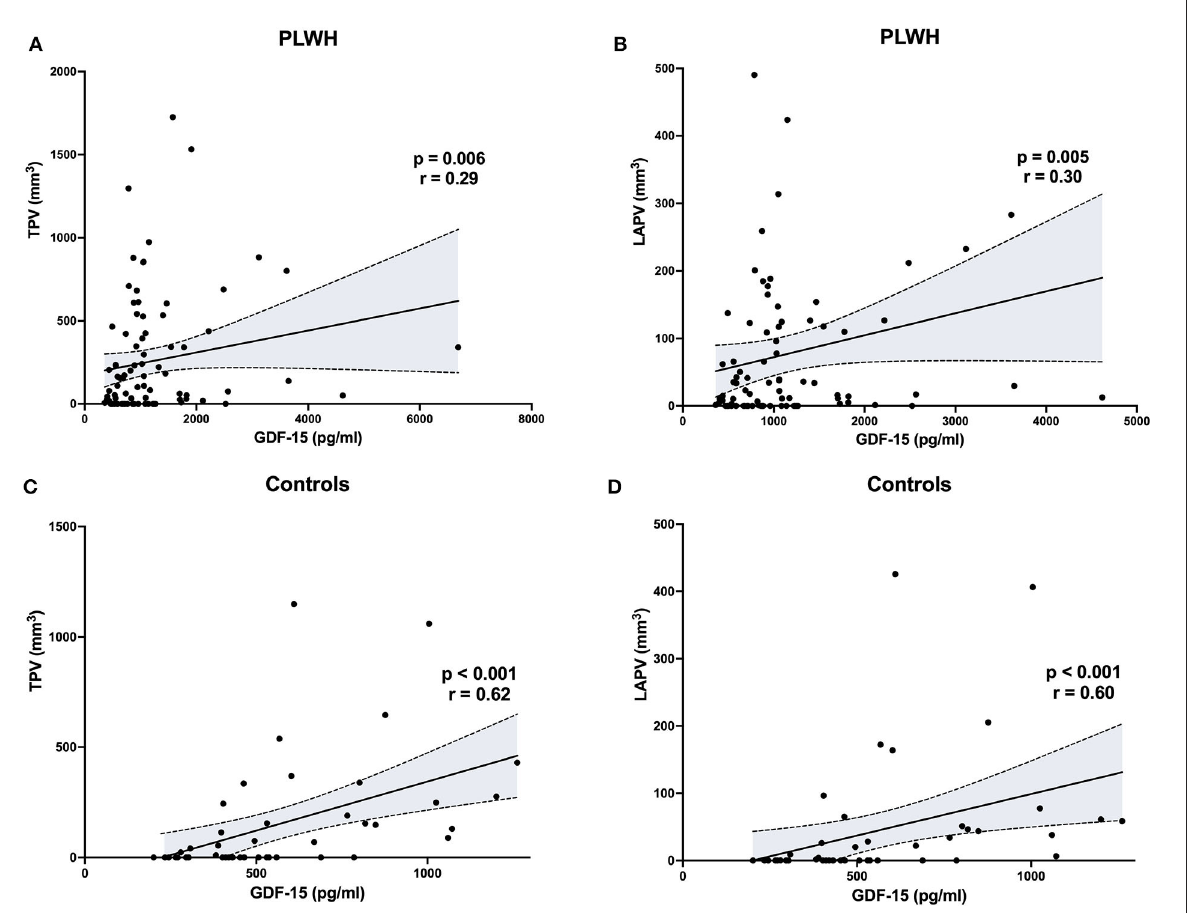
FIGURE1 Correlations between total or low-attenuation plaque volume (TPV, LAPV) and GDF-15 levels in people living with HIV and controls. The Spearman rank correlation test was used to identify associations. PLWH, people living with human immunodeficiency virus.